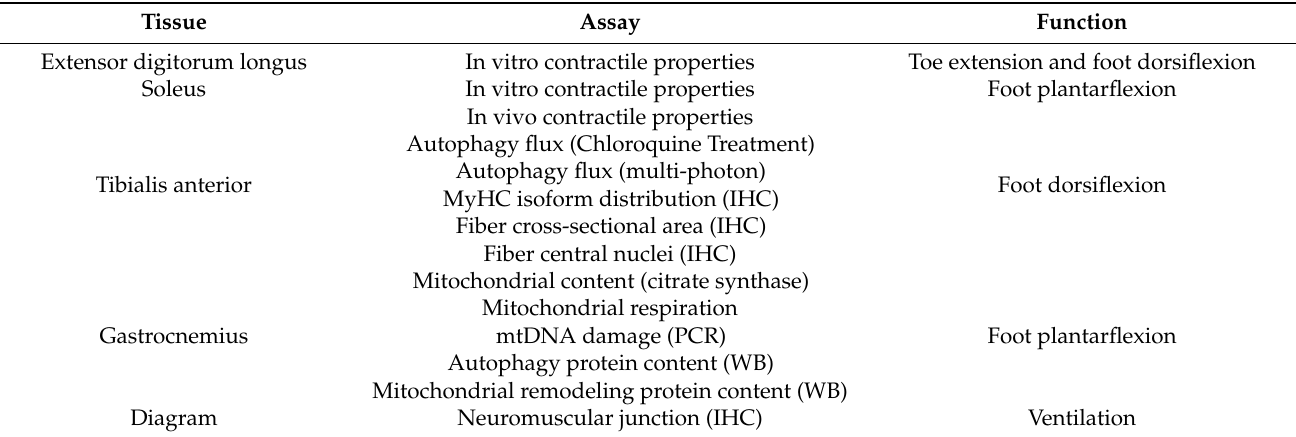
Table 1. Skeletal muscles collected postmortem, assays performed, and tissue function. Tissue Assay